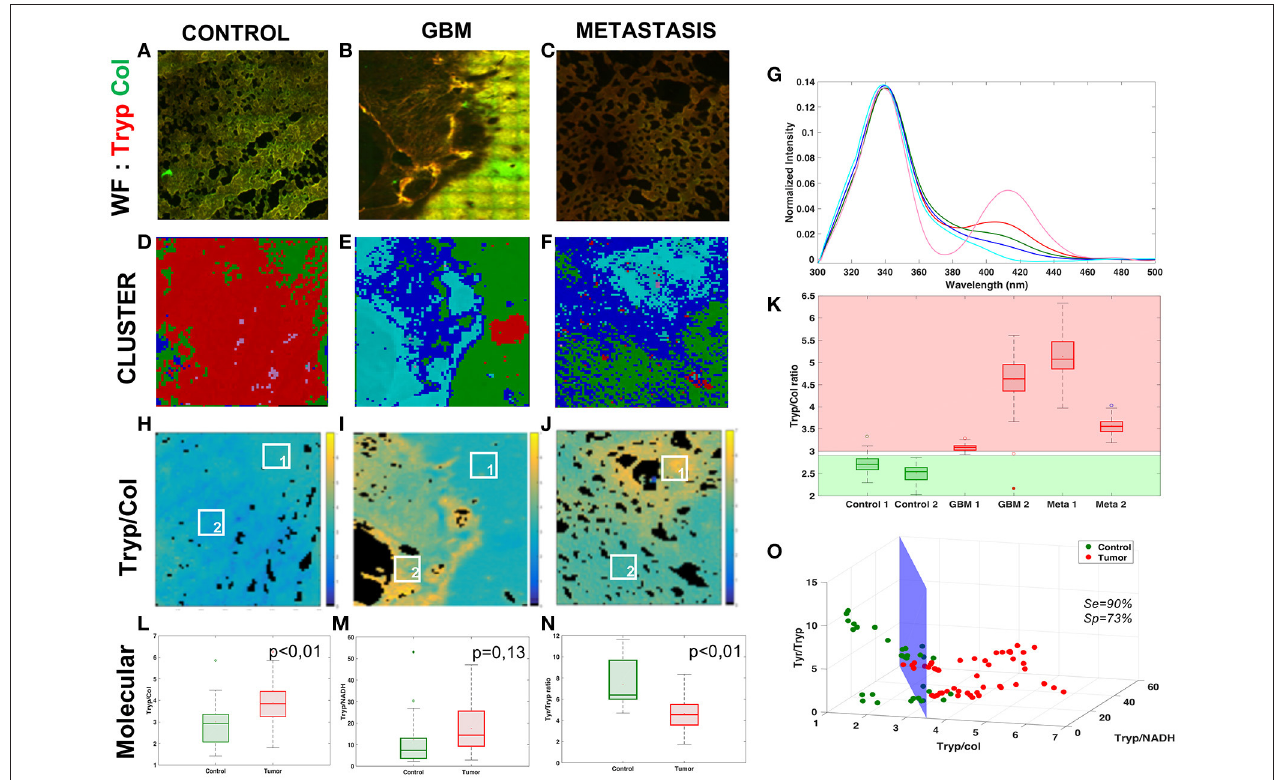
FIGURE 2 | Analysis of the Deep-UV data. Comparison of the three tissue groups control (A,D,H) , glioblastoma (B,E,I) and metastasis (C,F,J) with different analysis methods: wide-field(WF) imaging (A,B,C) , spectral clustering (D,E,F) with a 5-cluster decomposition shown on a graph (G) , map of the tryptophan/collagen ration (H,I,J) with comparison of selected ROIs (K) . Molecular analysis of the tryptophan/collagen ratio (L) , the tryptophan/NADH ratio (M) and the tyrosin/tryptophan ratio (N) combined in 3-D scatter discrimination plot (O)